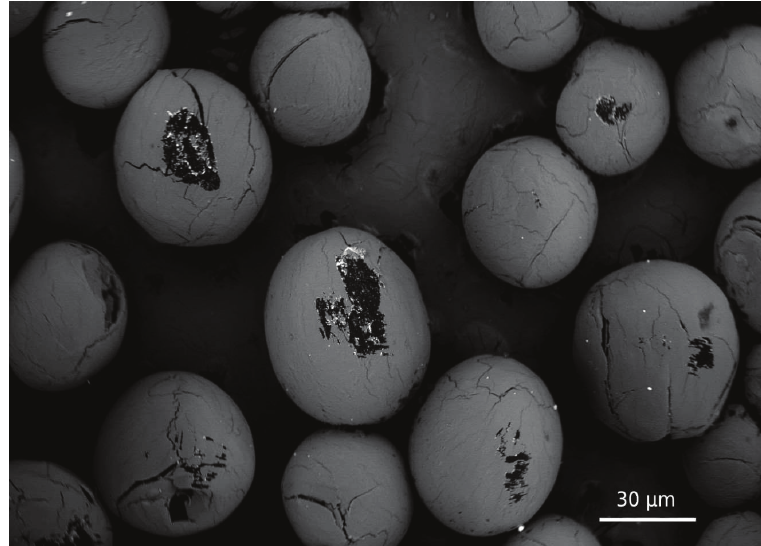
Fig. 8. SEM Photograph of the selected formula (AZSP4)